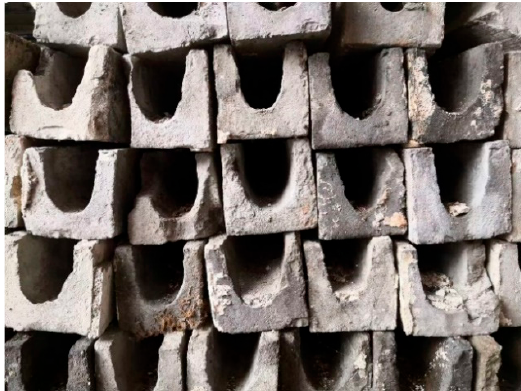
Figure 2. Cross-sectional shape of keel bricks.